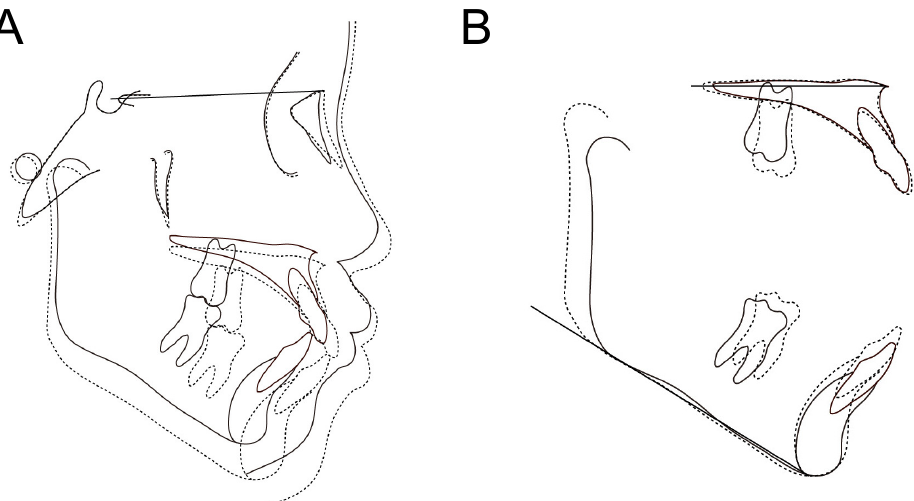
Figure 14. Superimposed images of Case 3 Overall (SN plane, reference point S) ( A ) Maxilla (palatal plane, reference point ANS) and mandible (mandibular marginal plane, reference point Me) ( B ).